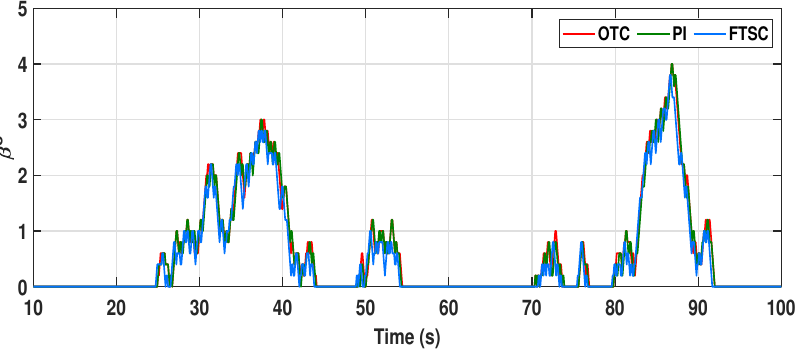
Figure 26. Experimental results for pitch angle ( β ) regulation signal given to the actuator for region III operation under varying wind profile case-II with different control